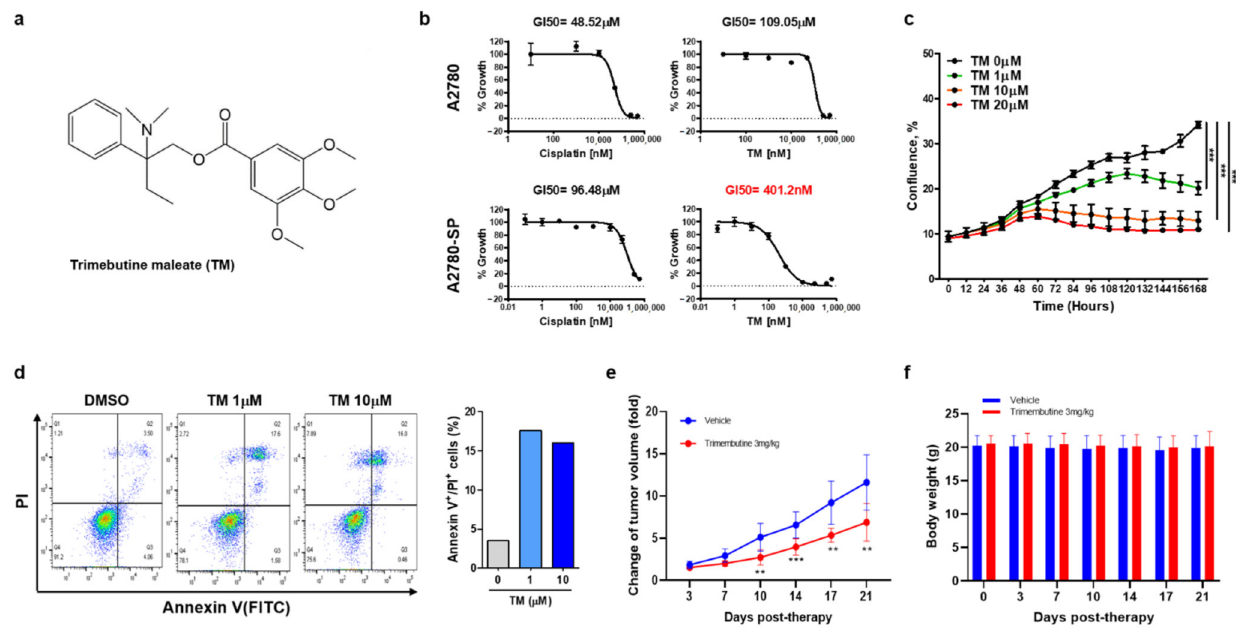
Figure 1. Trimebutine(TM) inhibits ovarian CSCs growth more specifically than ovarian cancer cells, and induces cell death. ( a ) Trimebutine maleate (TM) structure. ( b ) ATP-based cell viability was measured after 3 days (A2780) or 7 days (A2780-SP) of TM or cisplatin treatment at the indicated concentrations. Data are expressed as the mean ± SEM in triplicate. Nonlinear regression analysis was performed to obtain GI50 values using Prism 6. ( c ) The proliferation curve of A2780-SP cells was obtained using real-time live imaging for 60 h after TM treatment. The data are expressed as the mean ± SD of two or three independent experiments. *** p < 0.001. ( d ) AV/PI apoptosis assay. After 24 h treatment with either DMSO or TM, apoptotic cells were examined using flow cytometry. ( e ) The effect of tumor growth inhibition by TM in the A2780-SP xenograft model. ( f ) The effect of body weight change by TM in the A2780-SP xenograft model. The data are expressed as the mean ± SD of three independent experiments. ** p < 0.01, *** p <